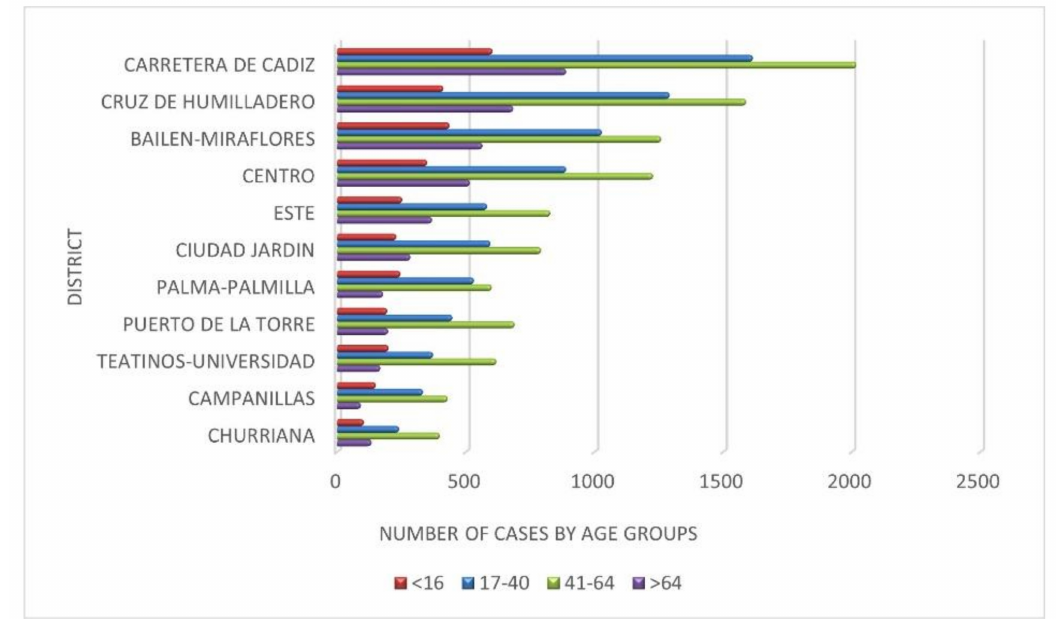
Figure 3. Number of infections by large age groups: young people “<16 years”, young adults “17–40”, adults “41–64” and the elderly “>64)”in social areas. Source: Author’s elaboration based on data from the Technical Subdirectorate of Information Management of the Andalusian Health Service (SAS), Regional